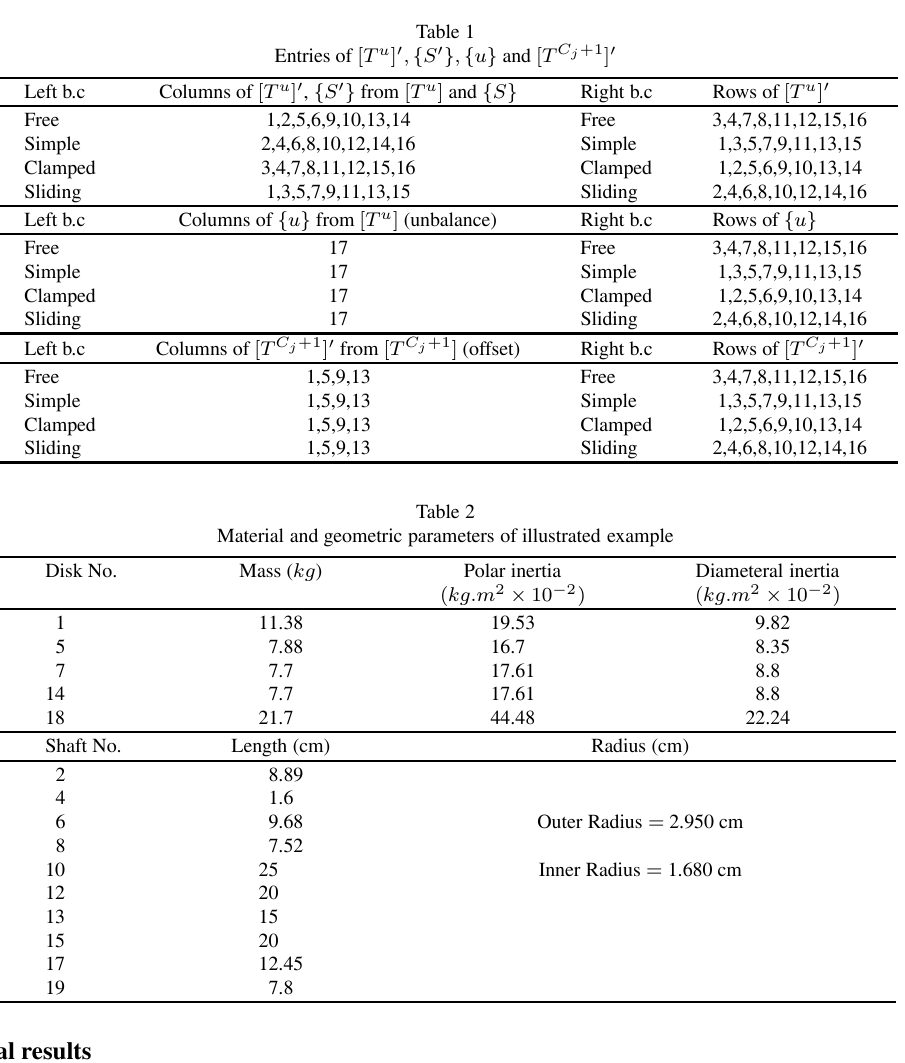
Table 1 Entries of [ T u ] (cid:3) , { S (cid:3) } , { u } and [ T C j +1 ] (cid:3)